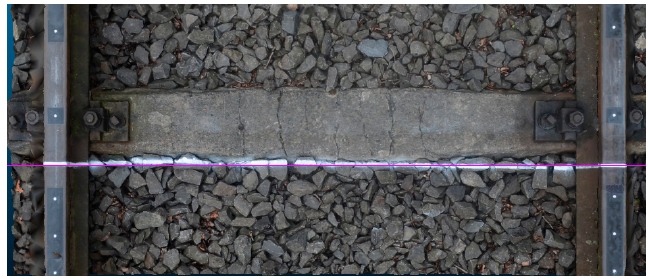
Figure 9. Generated 3D model of railway track with simulated structured light (SSL) profile.